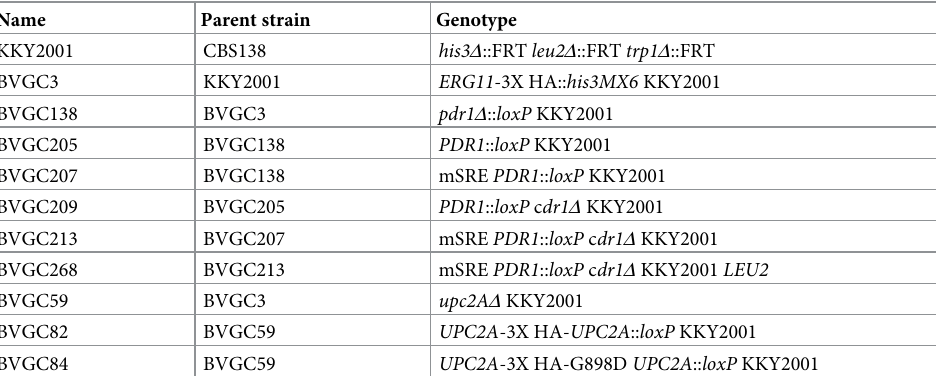
Table 1. Strains and relevant genotypes for C . glabrata cells used in this study.